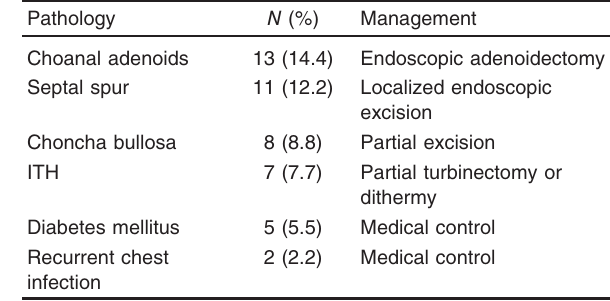
Table 4 Concurrent nasal anomalies or